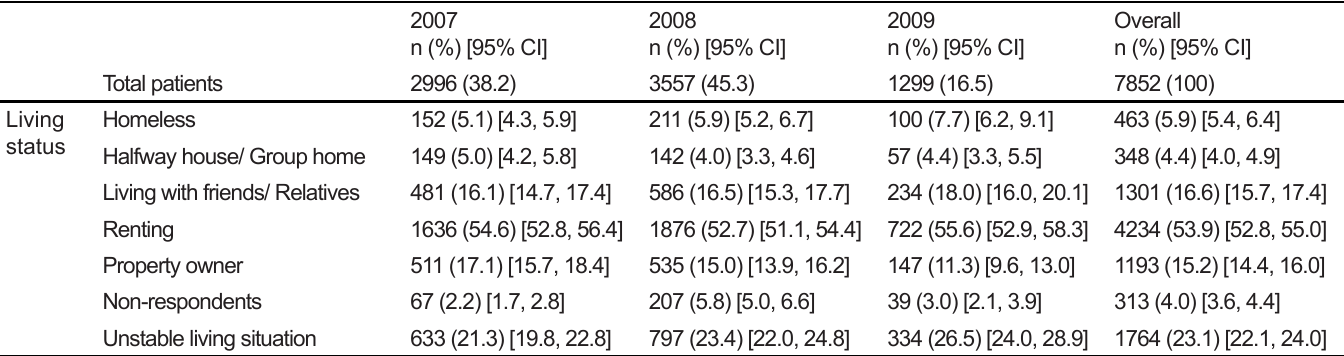
Table 3. Housing status of patients in the emergency